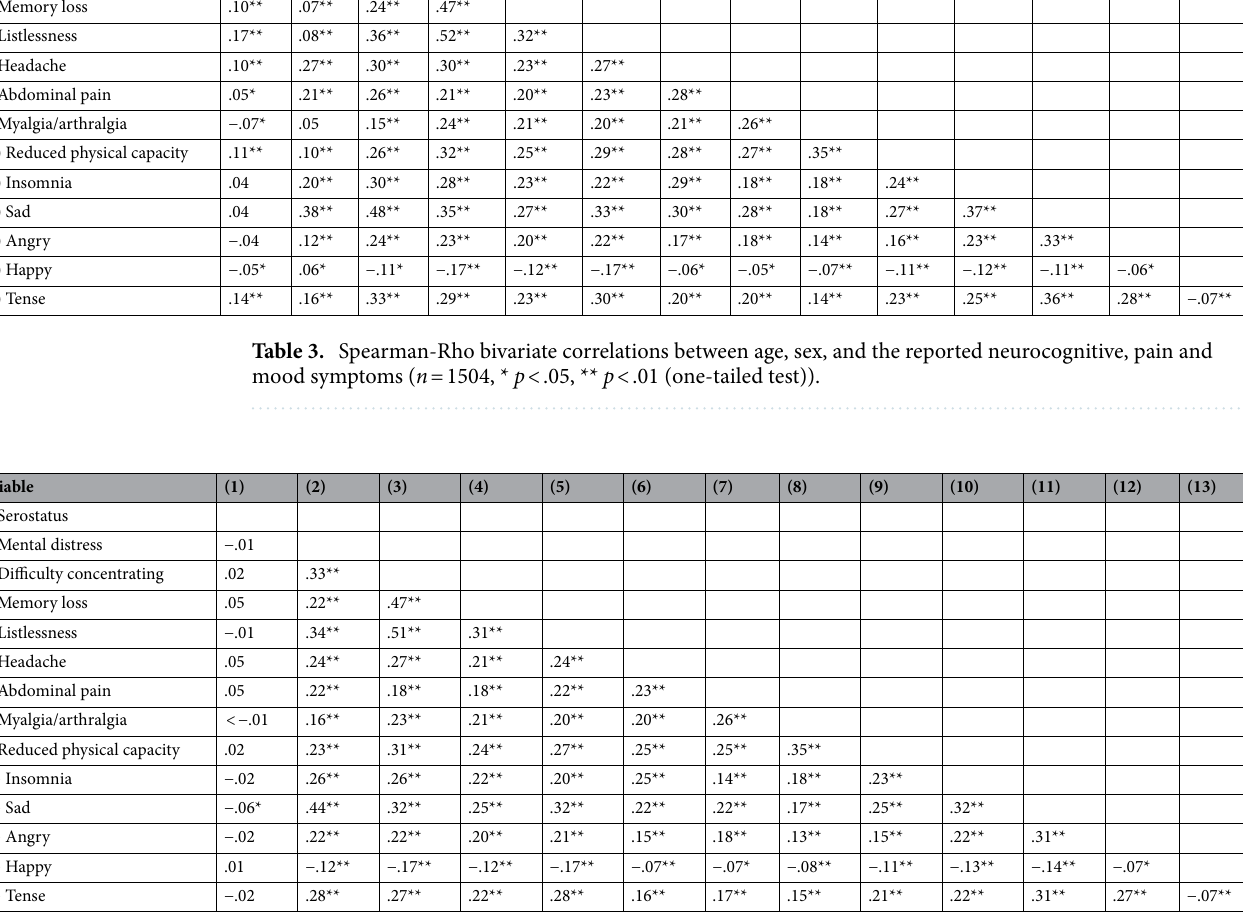
Table 4. Partial correlations between serostatus and neurocognitive, pain and mood symptoms (rank- transformed), controlling for age and sex ( n = 1504, * p < .05, ** p < .01 (one-tailed test)).